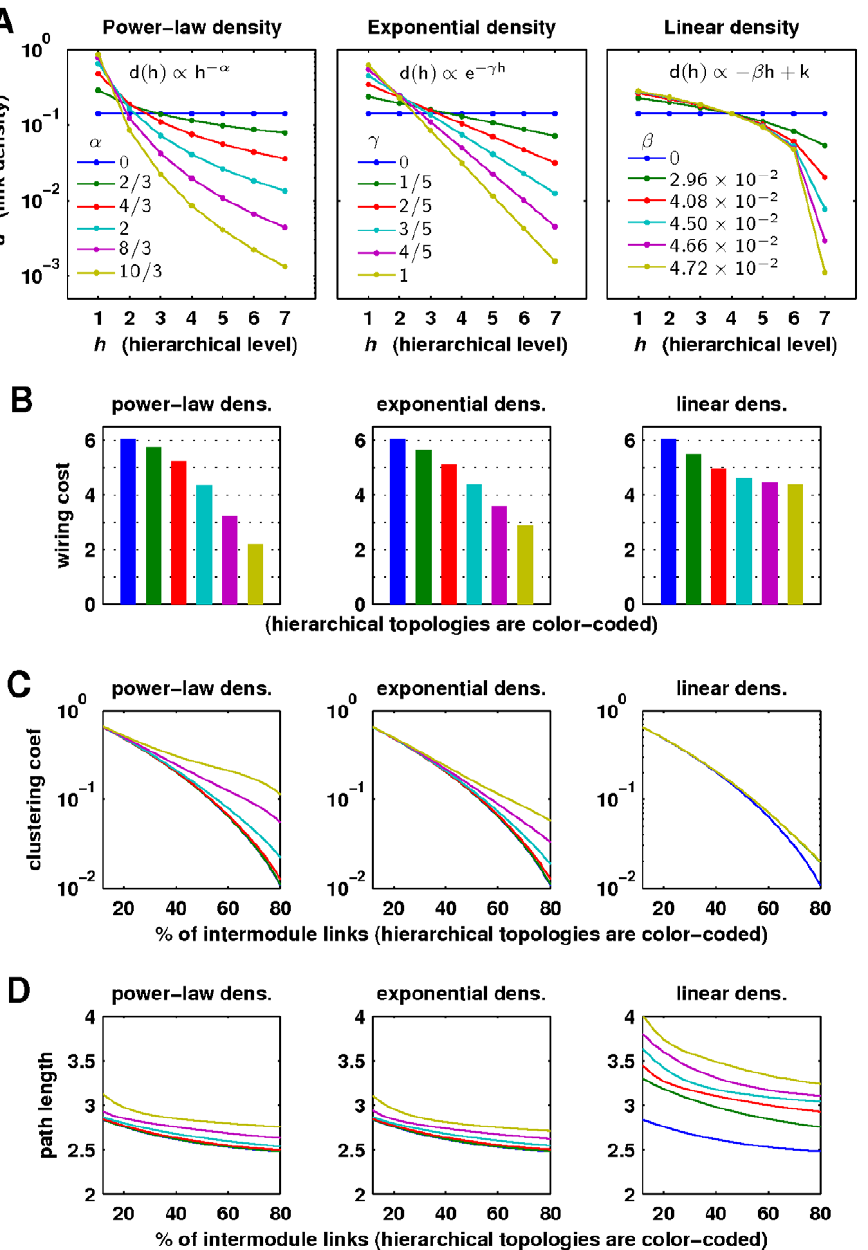
Figure 2. Properties of hierarchically modular connectivity. (a) Power-law, exponential and linear density scaling functions of the networks used in this study. (b) Dimensionless measures of wiring cost for each density scaling function in (a). The wiring cost was computed by equating synaptic cost with hierarchical-level number, and averaging the cost over all synapses. Hence, synapses in hierarchical level 1 were assigned a cost of 1 , synapses in hierarchical level 2 were assigned a cost of 2 , etc. Approximate values of the network (c) clustering coefficient and (d) characteristic path length across a range of randomizations of each hierarchical topology. Color-coding is the same as in (a).